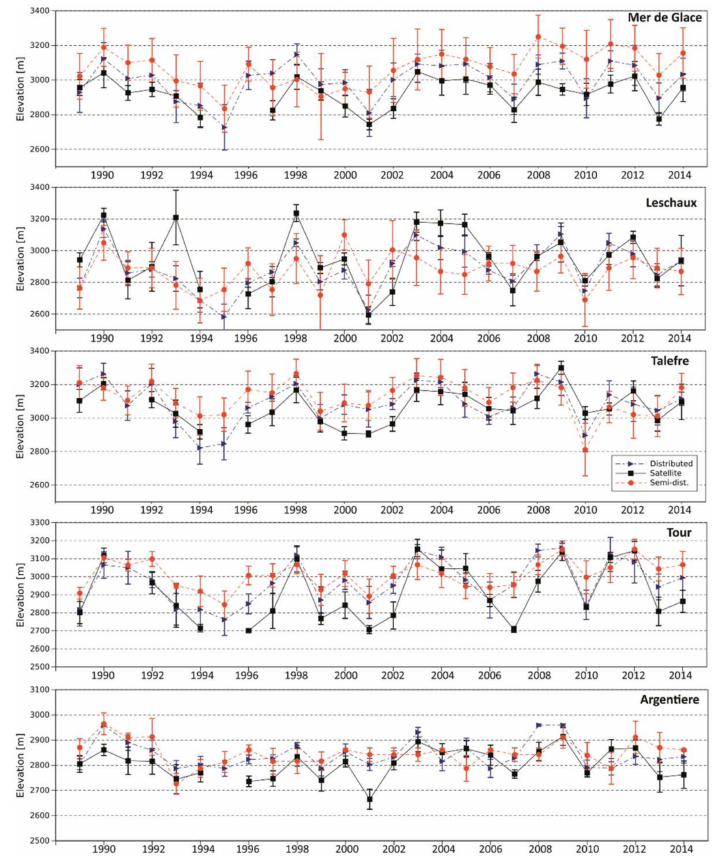
Figure 13. Observed and simulated evolution of the equilibrium-line altitude (ELA) for the five glaciers during the study period, based on the same dates as those for the satellite image